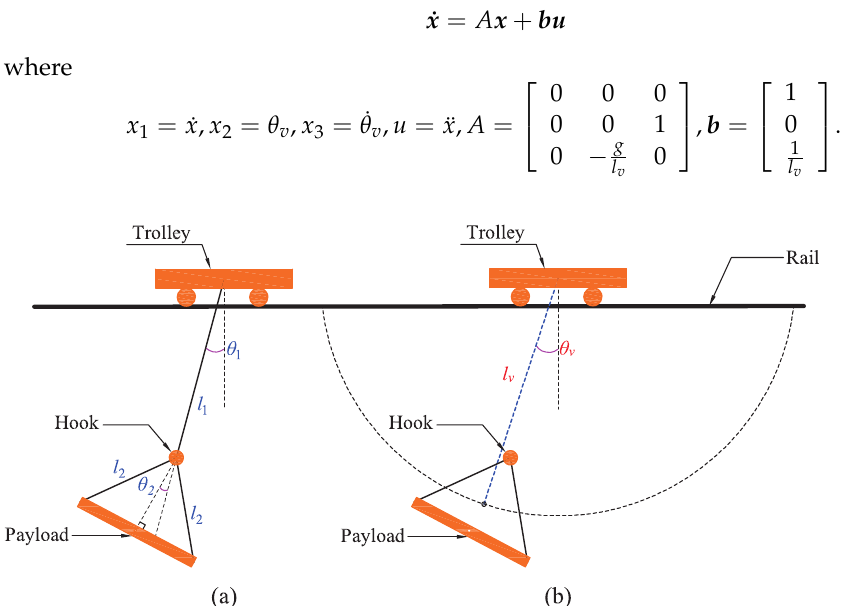
Figure 2. Models of the bridge crane. ( a ) with the double pendulum, ( b ) with the equivalent single